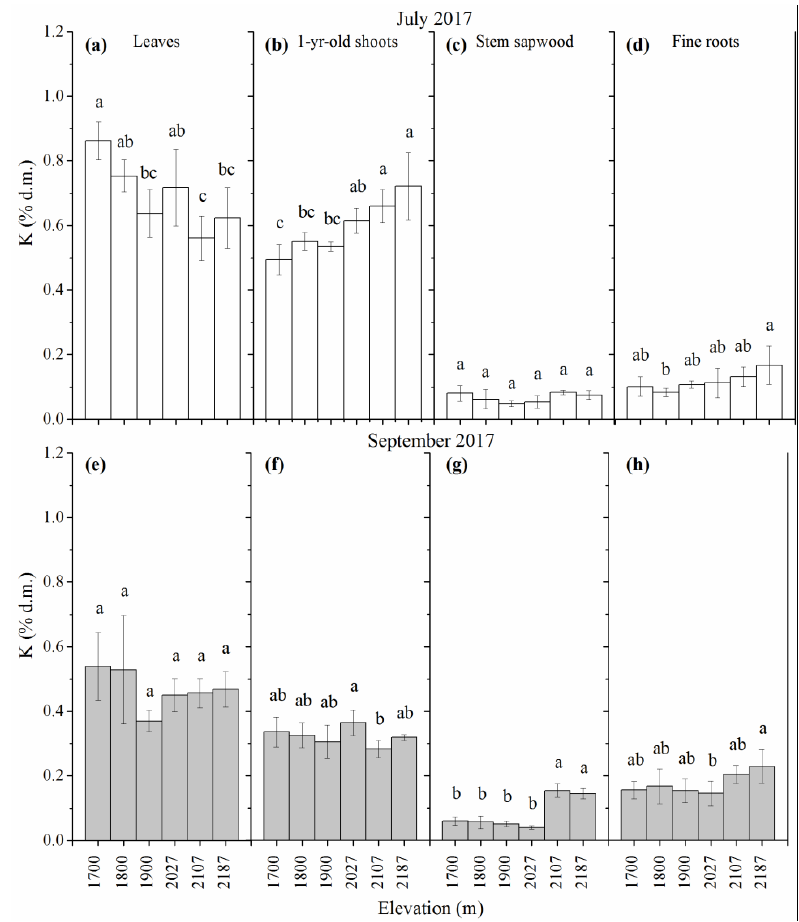
Figure 4. Seasonal tissues concentration (Mean ± 1SD; % of dry matter) changes in total potassium (K) of Betula ermanii trees along elevational gradients in Changbai Mountain ( n = 5 for each elevational site and tissue type). Different letters display significant differences at the 0.05 level among elevations as determined by Tukey’s HSD test.